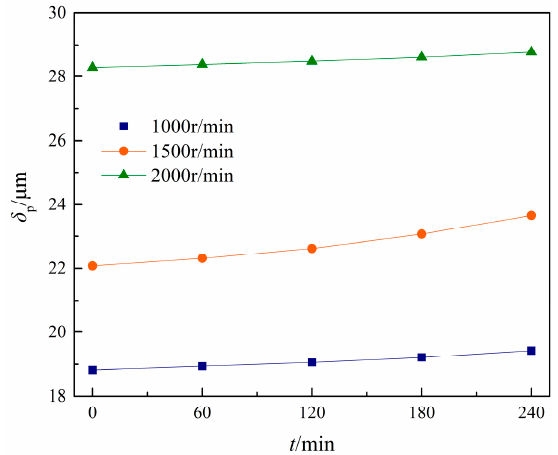
Figure 21. δ p at different rotating